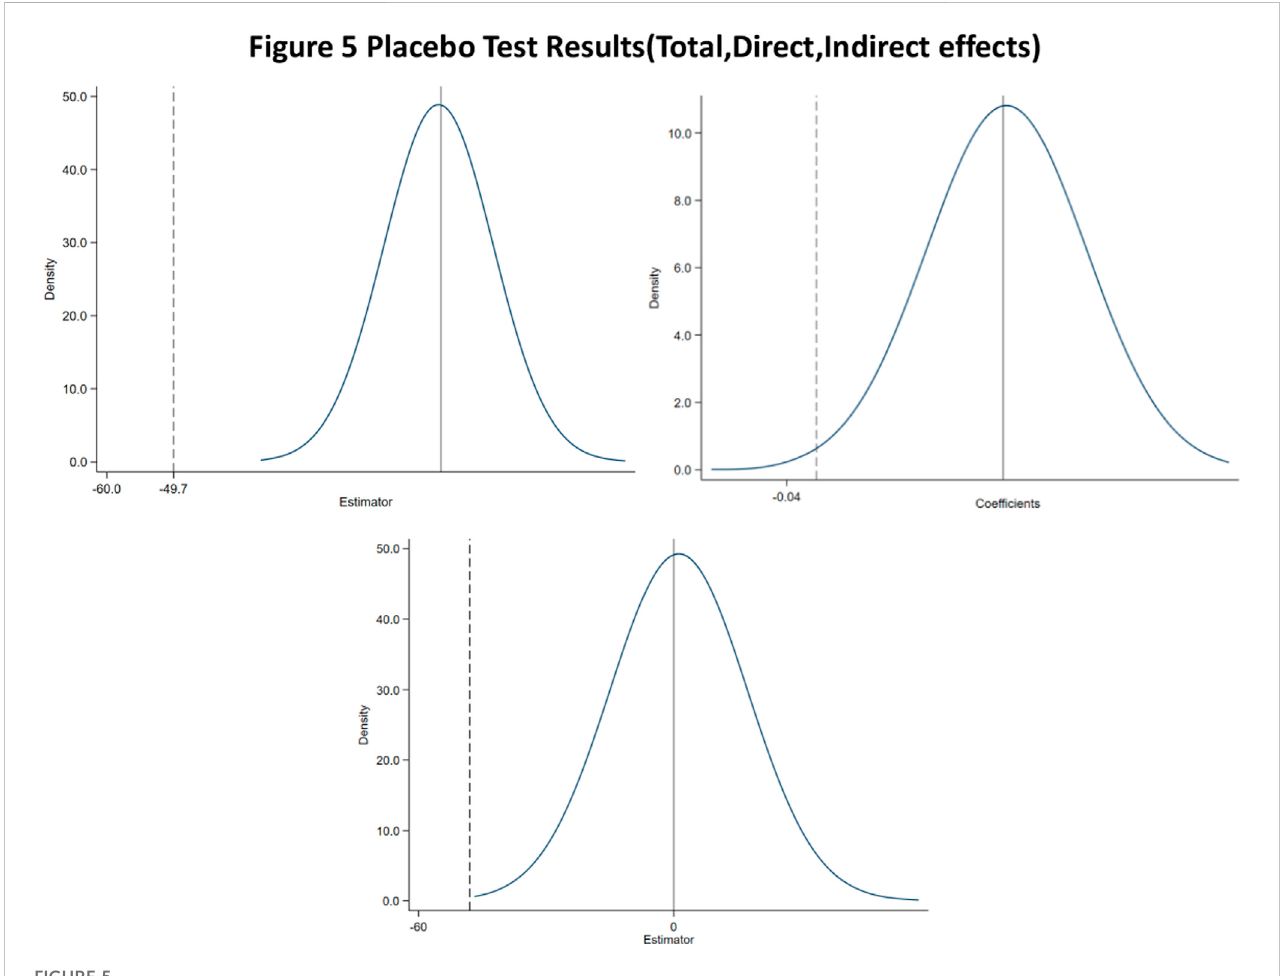
Placebo test results (total, direct, indirect